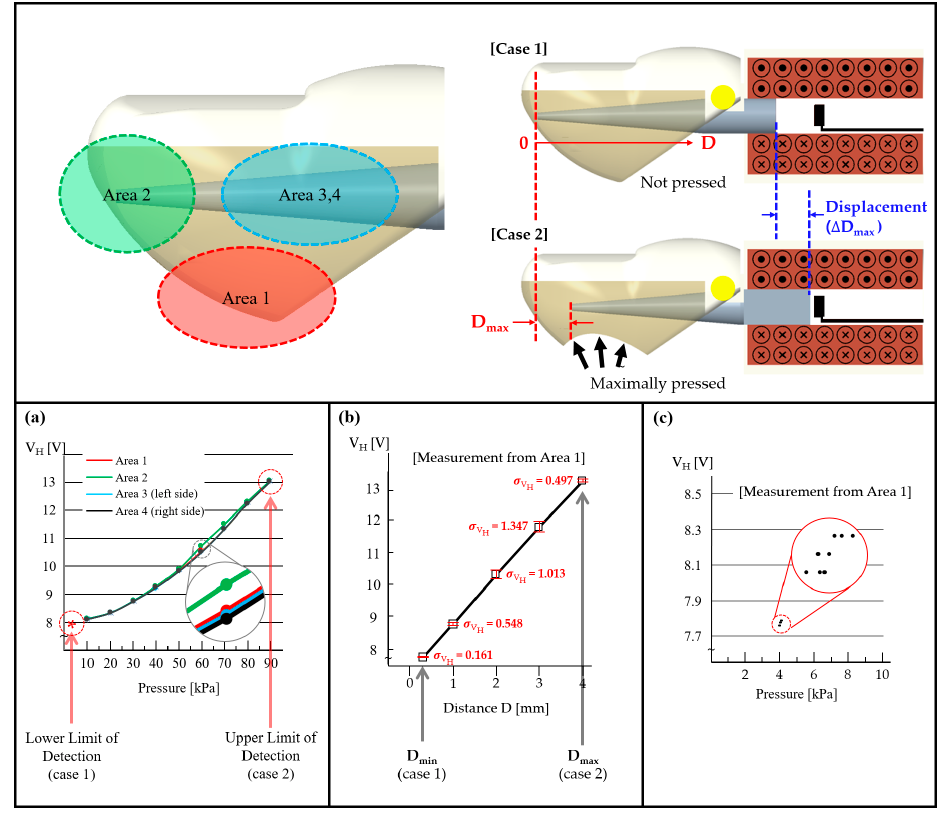
Figure 6. Pressure measurement from four sides of the fingertip. ( a ) Plot of V H versus pressure for different areas. Area 1 is the front portion of the fingertip whereas area 2 is the bottom portion. Areas 3 and 4 indicate the left and right sides of the fingertip, respectively (* denotes the lower limit of detection). ( b ) Plot of V H versus distance D with each tenth trial where error bars indicate the standard deviation. ( c ) Measurement of the lower limit of detection (LLOD) within area 1.